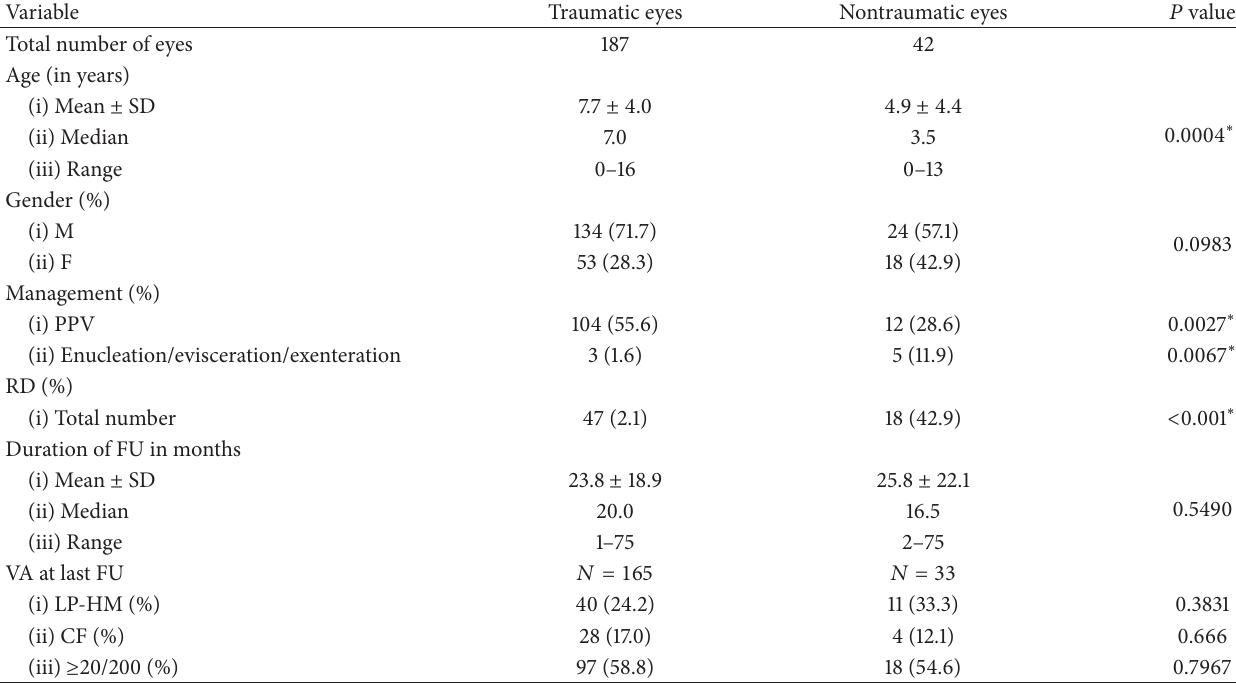
Table 11: A comparison between cases of vitreous hemorrhage caused by accidental trauma and nontraumatic cases.